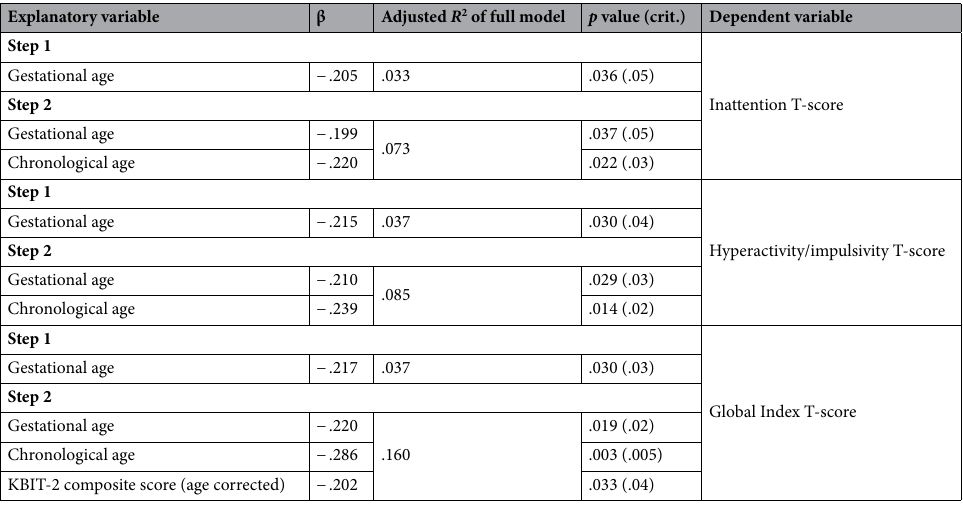
Table 3. Gestational age associated with ADHD symptoms while adjusting for demographic factors: results from stepwise regression analyses in the 105 participants with DS. Chronological age and KBIT-2 composite score of participants with Down syndrome are at time of ADHD measurement. FDR-adjusted critical values are presented next to p values, if a p value is below or at the critical value it remains significant after controlling for multiple